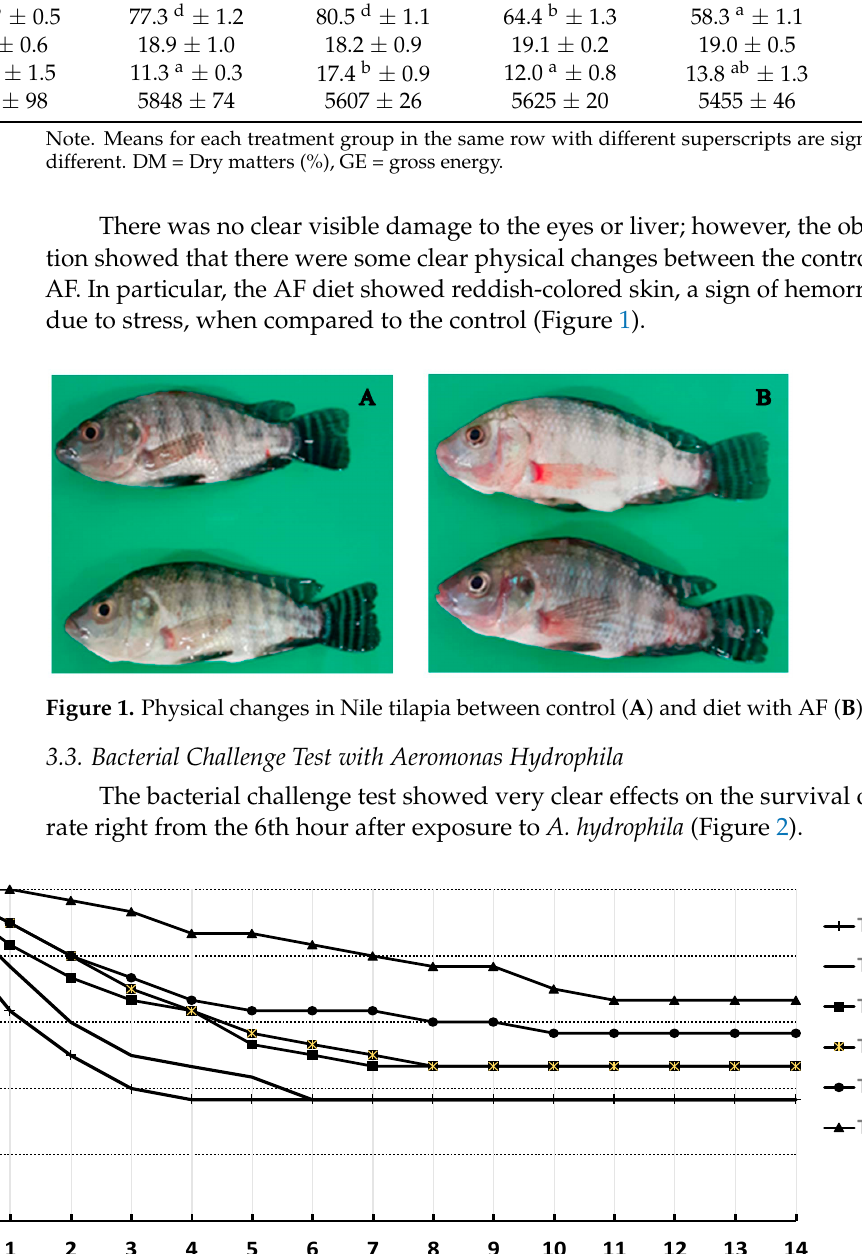
Figure 2. Survival (%) of tilapia after being challenged by A. hydrophila . The survival rate dropped right from Day 1 and reached below 35% survival in the case of the control and OMC after Days 4 and 6, respectively, whereas AFMMDA maintained a survival rate above 80% until Day 6 and above 65% until it stabilized and maintained that level from the 13–14th days. The survival rate after the challenge between treat- ment groups and control is shown in Figure 2. With regards to the bacterial challenge, fi sh survival rates were signi fi cantly higher with the supplemented AFMMDA diet and AFOMC diet when compared with the Control treatment. Interestingly, when fi sh were not exposed to bacteria, survival remained high (>85%), and there was a clear sign of im- proved survival due to the supplementation of OMC and MMDA. Conversely, protein intake results were signi fi cantly higher in the control and OMC both with and without bacterial challenges. However, the speci fi c growth rate (SGR), weight gain, daily weight gain (DWG), protein e ffi ciency ratio (PER), and overall food conversion e ffi ciency (FCE) did not show any di ff erences between the challenge and non-challenge periods. In all the groups challenged with bacteria, after 3 h of bacterial immersion, all fi sh became passive and often gathered in a corner of each aquarium. After 6 h, mortality started to occur. By the fi rst day, the fi sh showed a reluctance to eat, reduced feed intake, and darkened skin. By the second day, focal hyperemia of the skin appeared over the pectoral fi ns. From the fourth day, fi n rot was observed, especially on the tips of the pec- torals and caudal fi ns. From day 6 until day 10 after the challenge, fi sh mortality de- creased, and some fi sh may have been more tolerant as they started eating, but most of the fi sh had patches on the body, and fi n rot and dark-colored skin were observed (Figure 3). From day 11 until day 15 after the challenge, fi sh skin became darker and fi n rot was clearer. Interestingly, most of the remaining fi sh in AFMMDA were more tolerant (66.67 ± 8.82%) than other treatments, despite being challenged by A. hydrophila . Figure 3. Clinical fi ndings (patches and dark-colored skin ( left ), fi n rot ( right ) during the challenge with Aeromonas hydrophila. 3.4. Hematological Results No signi fi cant di ff erence was found in the RBC (red blood cells), Hct (hematocrit), AST (Aspartate Aminotransferase), LDH (lactate dehydrogenase), and MCV levels among